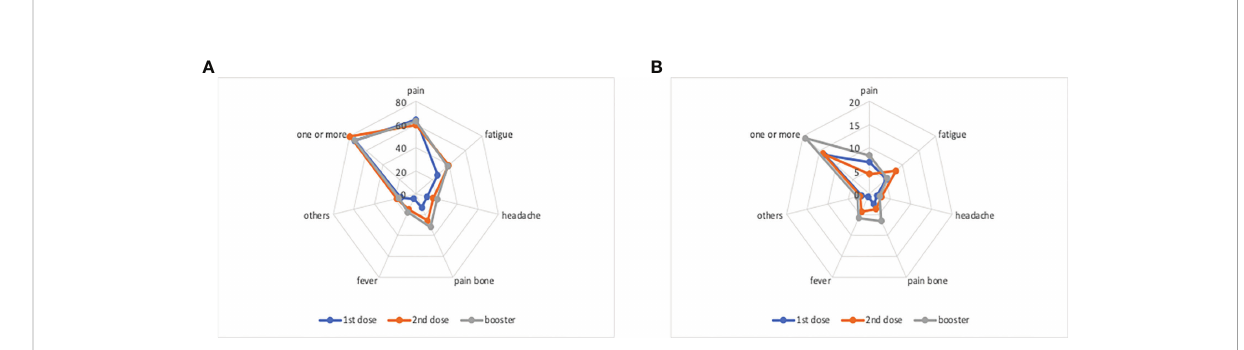
FIGURE 1 Prevalence of solicited adverse events within 7 days following third-dose vaccination. (A) Any-grade local and systemic adverse events. (B) Severe local and systemic adverse events.